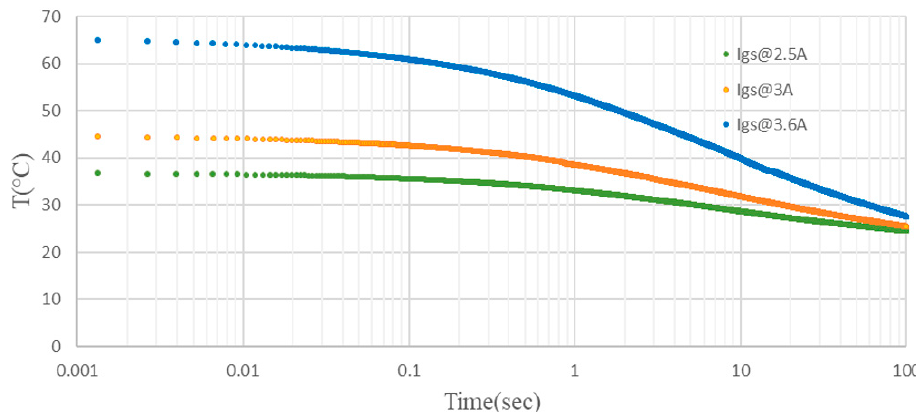
Figure 18. Trend of I g.